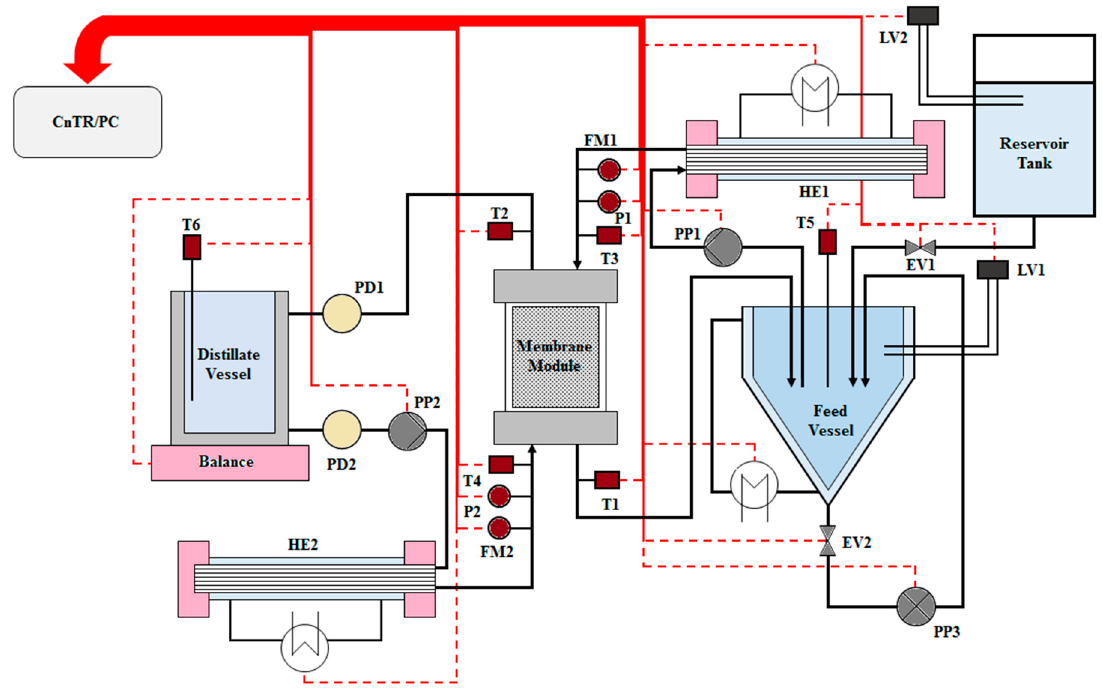
Figure 2. Membrane distillation plant used in direct contact configuration.